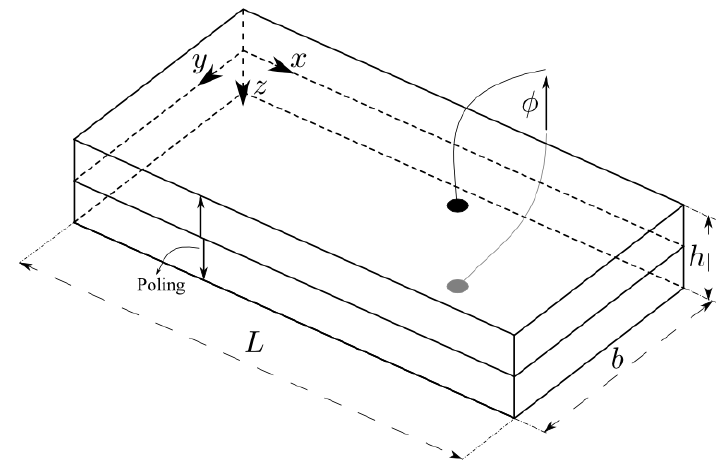
Figure 4. Bimorph beam with equally-thick piezoelectric